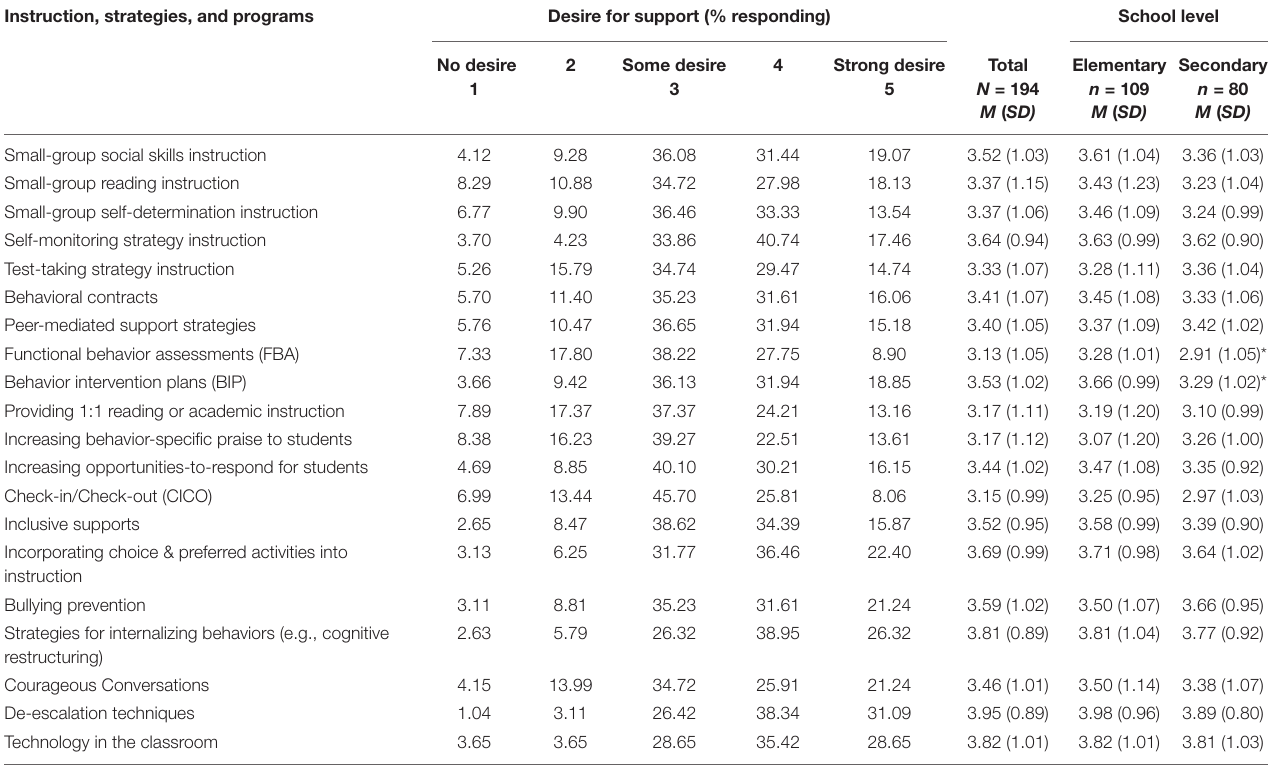
TABLE 4 | Desire for professional development on how to implement educational practices. Instruction, strategies, and